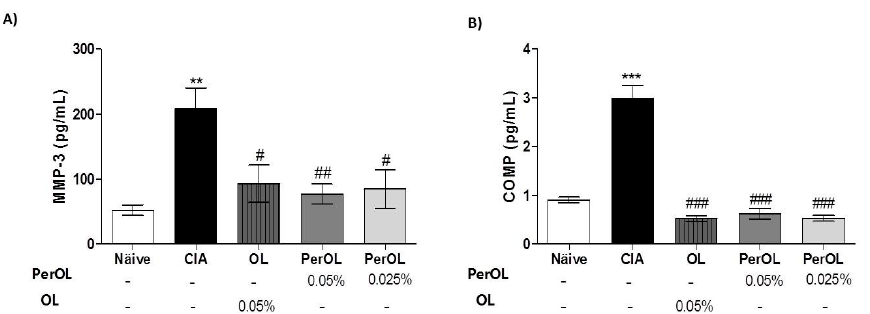
Figure 2. Measurement of serum levels of MMP-3 ( A ) and COMP ( B ) levels. They were measurement by ELISA com- mercial kits. Data represent mean ± S.E.M., n = 12. ** p < 0.01 and *** p < 0.001 vs. SD-Naïve control group, # p < 0.05, ## p < 0.01 and ### p < 0.001 vs. SD-CIA control group.